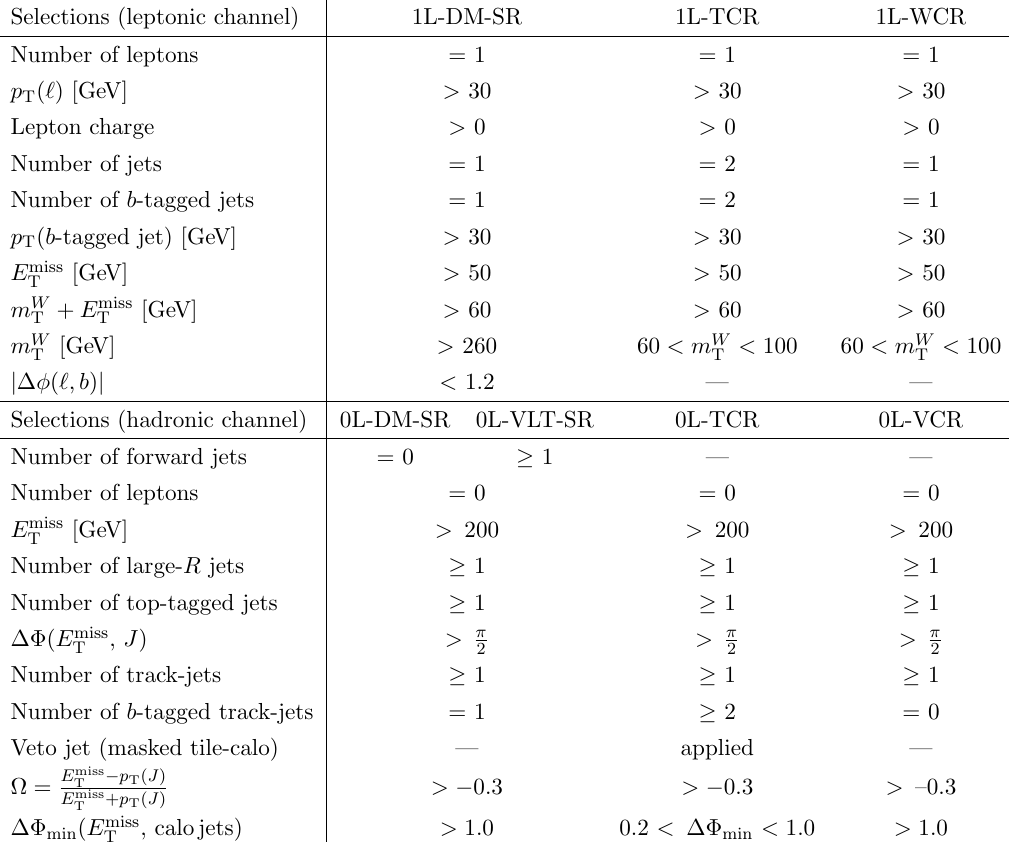
Table 1 . Overview of the event selections used to de(cid:12)ne the signal and control regions.